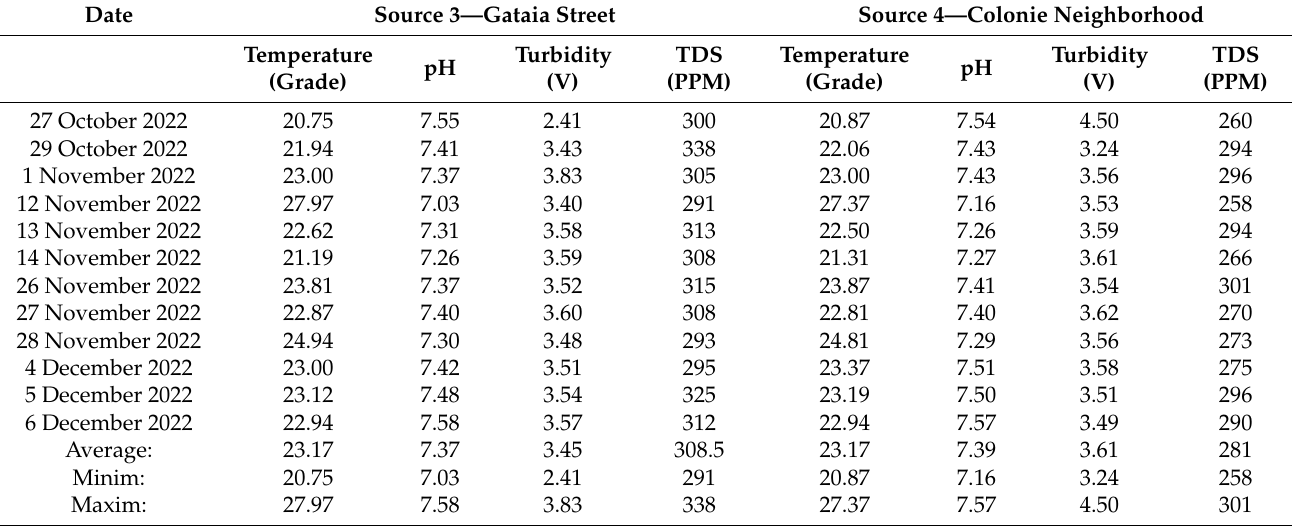
Table 4. Water sources three and four results.